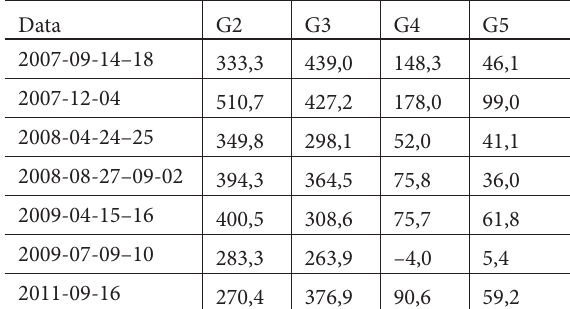
vimetro nulio slinktis buvo padidėjusi net iki 510 μgal per parą. Mažesnė nulio slinktis g4 ir g5 gravimetrų. gravimetrų paros nulio slinkties kitimas pavaizduotas 5 paveiksle.